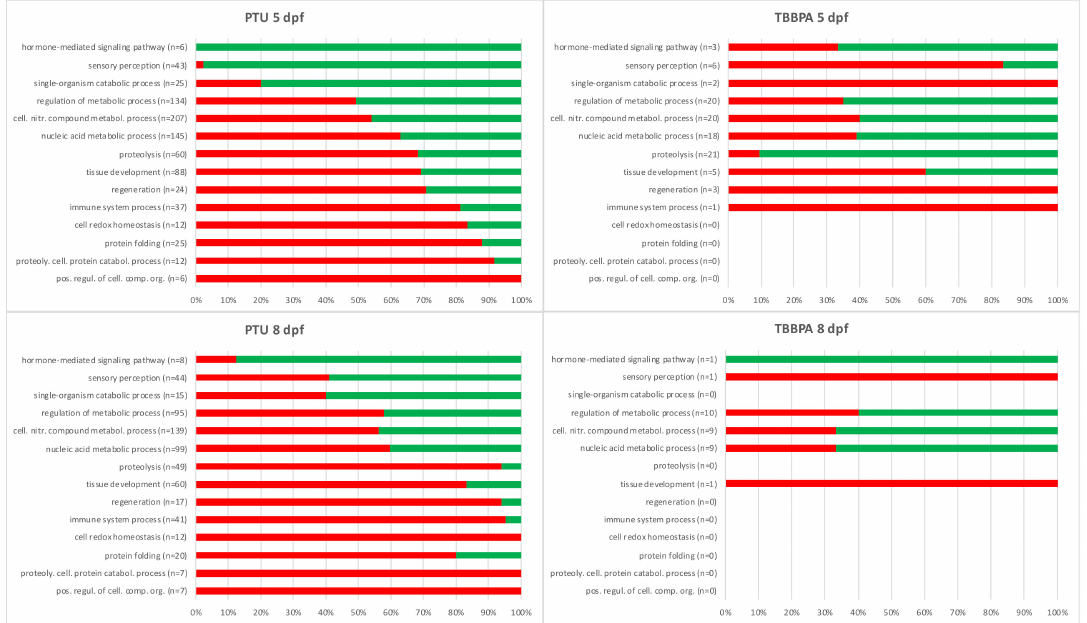
Figure 3. Overview of the percentage of up-regulated (red) or down-regulated (green) transcripts in the 14 different GO classes that were enriched in at least one of the five cluster groups. All treatments were sorted in the same order as for PTU 5 dpf, to enable to visualize the change of response pattern between the time points and